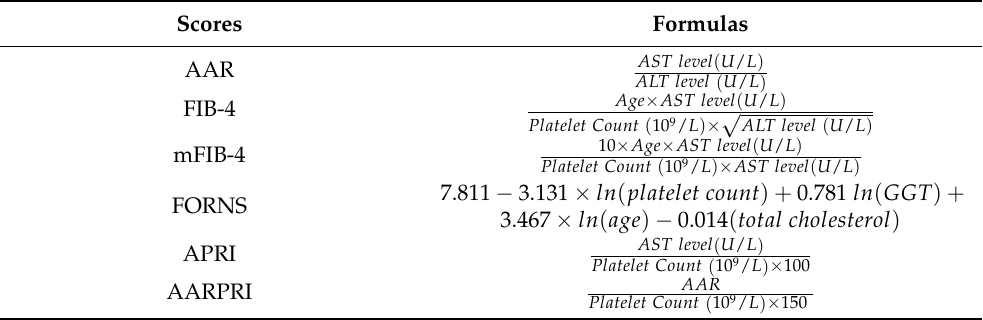
Table 1. Non-invasive scores for liver fibrosis with their associated